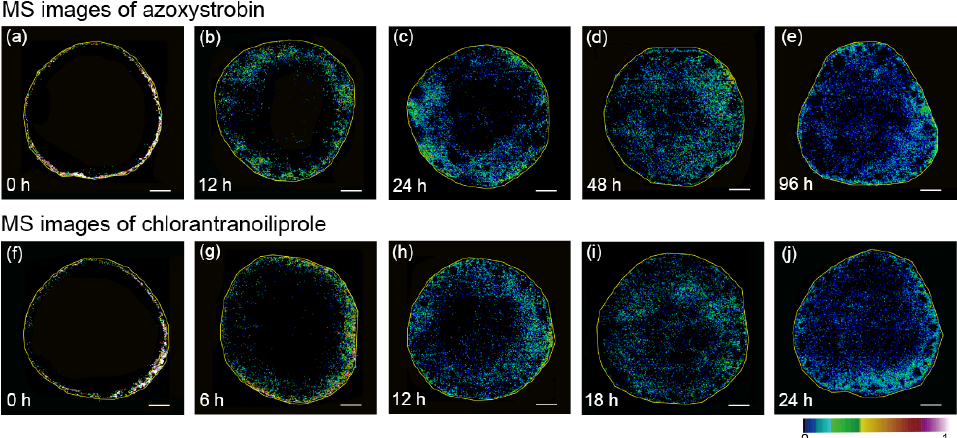
Figure 5. MS images of azoxystrobin ( a ) 0 h, ( b ) 12 h, ( c ) 24 h, ( d ) 48 h, and ( e ) 96 h after application. MS images of chlorantraniliprole ( f ) 0 h, ( g ) 6 h, ( h ) 12 h, ( i ) 18 h, and ( j ) 24 h after application. Scale bar of 5 mm.